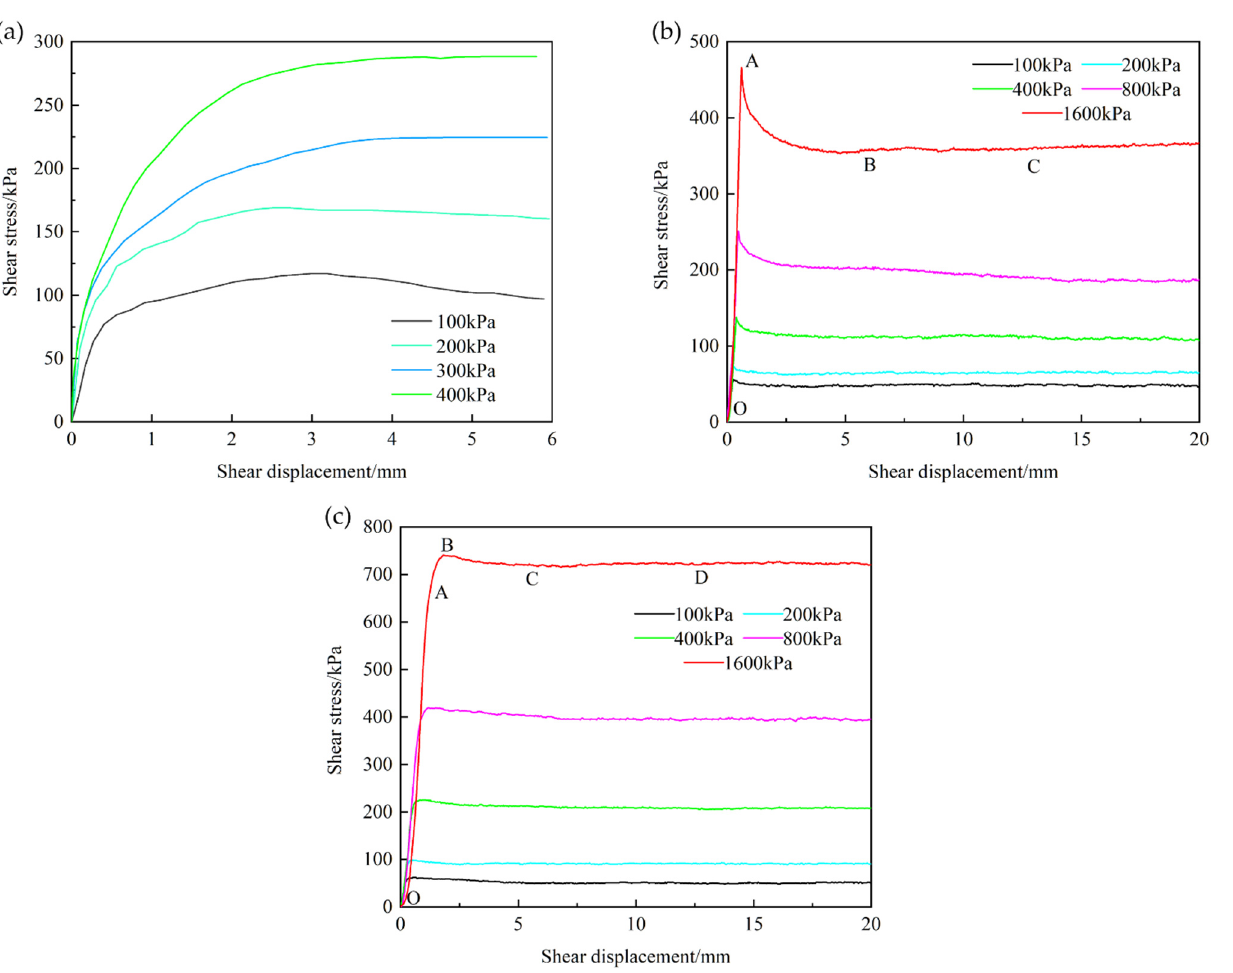
Figure 7. Relationships between shear stress and shear displacement: ( a ) clay soil; ( b ) clay–metal interface; ( c ) clay–mortar interface. interface; ( c ) clay–mortar